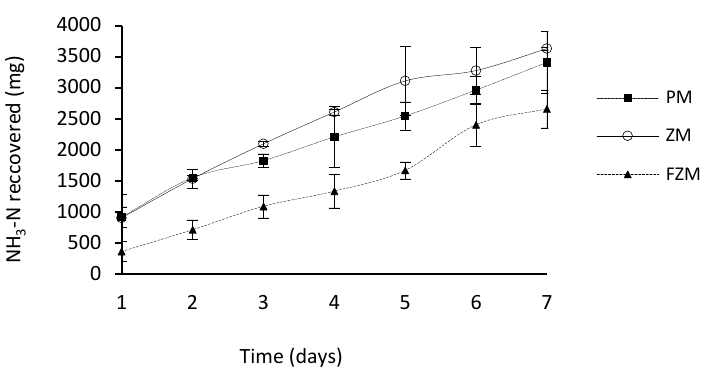
Figure 5. Mass of NH 3 –N recovered in the acidic solution for three di ff erent types of ePTFE tubular membranes (experiment 1). Data points are means ± s.d. of duplicate experiments.